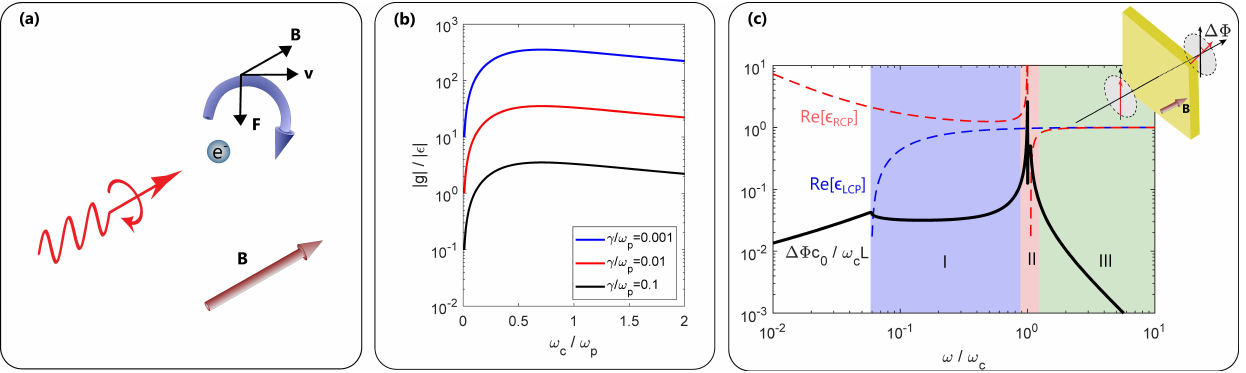
Figure 2. Nonreciprocity in magnetized plasmonic materials. ( a ) Due to the Lorentz force, a magnetic bias B moves the free electrons of a plasma in circular motion (cyclotron motion). Circularly polarized (CP) electromagnetic waves of opposite handedness interact differently with these rotating electrons; hence, at the macroscopic level, a different effective permittivity is “seen” by left-handed CP and right-handed CP waves. ( b ) Gyrotropy ratio as a function of the cyclotron frequency for different values of the loss coefficient. This ratio, which indicates the strength of certain nonreciprocal effects, can be maximized with a proper choice of parameters, ad discussed in the text. ( c ) Dispersion behavior of the Faraday rotation angle (solid black) for a plasmonic material with ω p = ω c /4. The dashed lines represent the permittivity of the eigenmodes in the bias direction. The RCP mode exhibits a resonance at ω = ω c . At resonance (red region), Faraday rotation is peaked, however, losses and dispersion are significant. The high-frequency region (green) is the most common regime of operation for magneto-plasmonic components, while the region below resonance (blue) is promising for broadband dispersionless nonreciprocity.